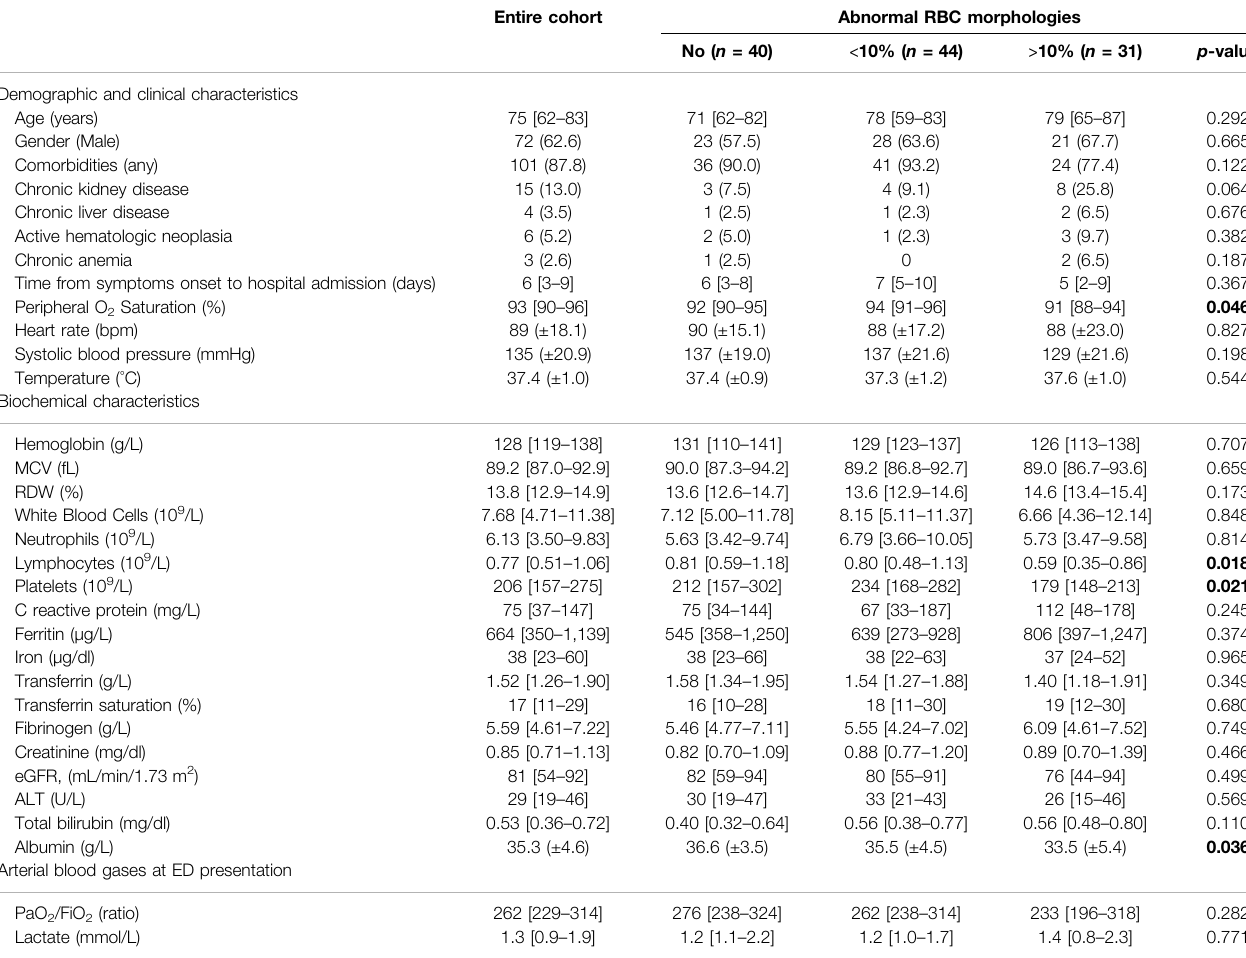
TABLE 1 | Baseline demographic, clinical and biochemical characteristics of the entire cohort and according to the presence of RBCs abnormalities at the peripheral blood smear.